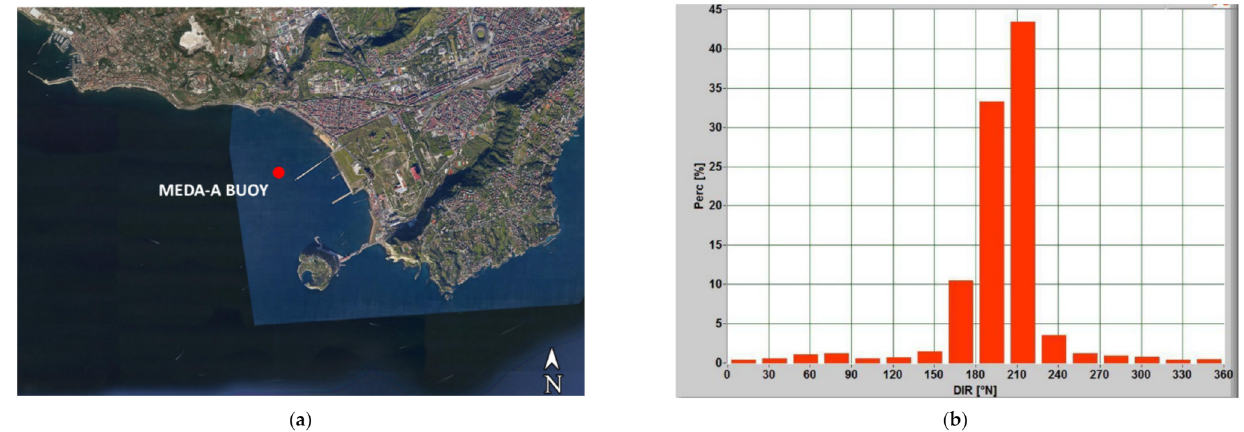
Figure 14. ( a ) Location of the MEDA-A buoy; ( b ) histogram of wave direction for angular sectors of 22.5 ◦